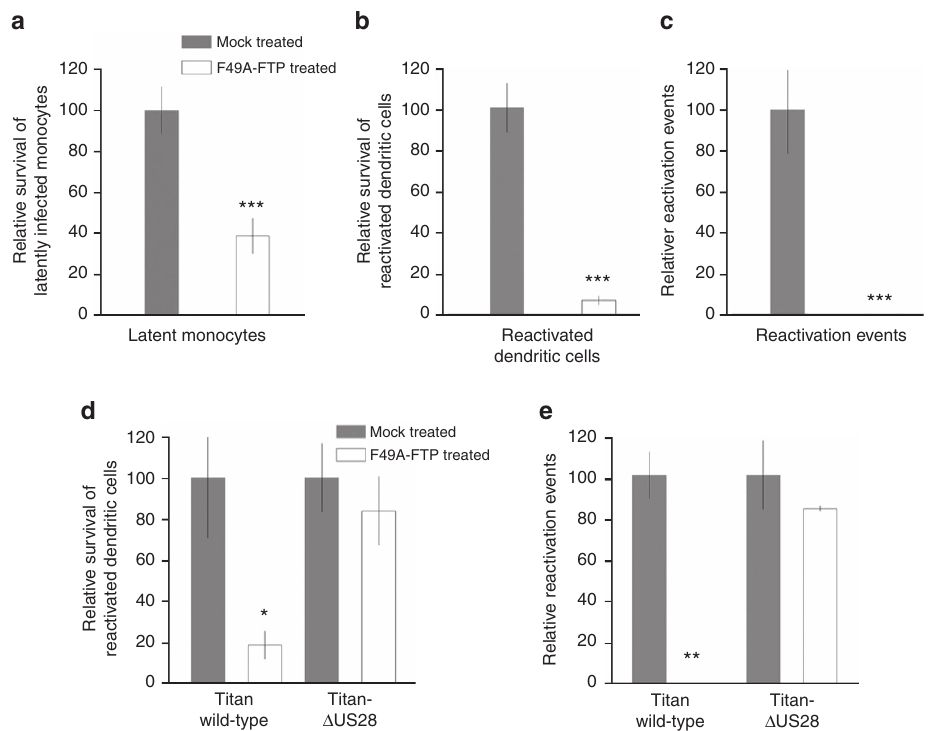
Figure 4 | F49A-FTP kills experimentally latently infected monocytes, reducing HCMV reactivation events. CD14 þ peripheral blood monocytes were isolated and experimentally infected at an MOI of 5 with HCMV SV40-GFP-TB40E wild type that led to a mean average of 10.9% latently infected cells. After 24h, F49A-FTP was added to monocyte cultures, and incubated for 72h. Changes in the number of GFP-positive cells was observed by fluorescence microscopy and compared with a mock-treated latently infected cell controls that was set at 100% ( a ). These monocytes were then differentiated using granulocyte-macrophage colony-stimulating factor (GM-CSF) and interleukin-4 (IL-4) stimulation followed by LPS treatment to mature dendritic cells (mDCs). Similarly, changes in the percentage of GFP-positive mDCs were then measured ( b ). Finally, the cells shown in b were co-cultured with fibroblasts for 2 weeks and the numbers of IE foci were counted ( c ). Means and error bars (showing s.d.) were generated from five independent experiments. ( d ) Monocytes were isolated and experimentally infected with either HCMV Titan wild-type or HCMV Titan with a US28 deletion at an MOI of 5. Cultures were then either mock-treated with PBS or treated with F49A-FTP for 3 days and then reactivated by differentiation into mDCs as above. Using the UL32-GFP tag on these viral isolates, reactivated dendritic cells were then counted and compared with levels of reactivation of monocytes infected with Titan wild-type virus in the absence of drug that was set to 100%. ( e ) After co-culture with reporter fibroblast cells, incubation for 2 weeks and staining for IE, reactivation events were quantified. Means and error bars (showing s.d.) were generated from three independent